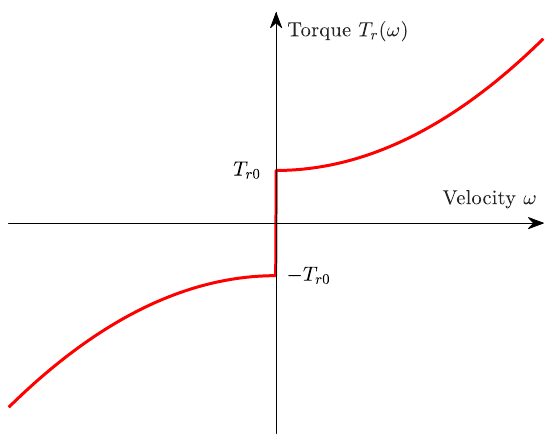
Figure 1. Nonlinear friction characteristic T r ( ω )